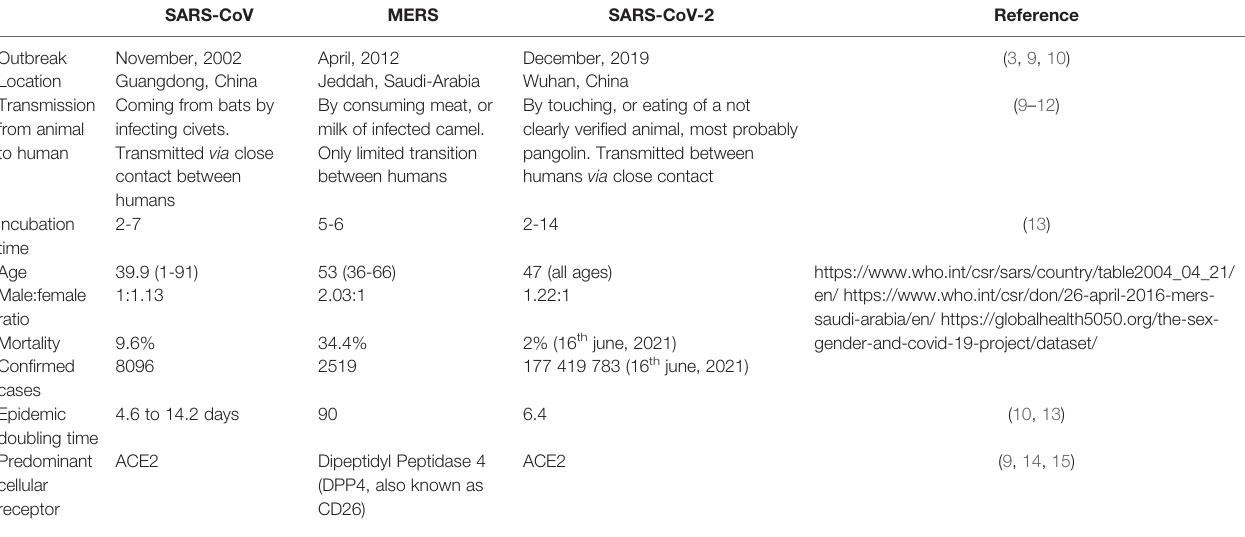
TABLE 1 | Key comparison of geographical location and epidemiology data of SARS-CoV, MERS and SARS-CoV-2 caused infections. SARS-CoV MERS